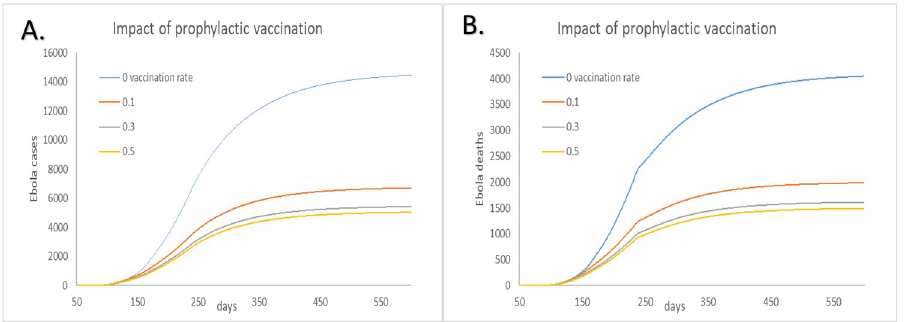
Fig 8. Impact of prophylactic vaccination of different proportions of HCW on cumulative Ebola cases and deaths. A: Cumulative cases. B: Cumulative deaths.